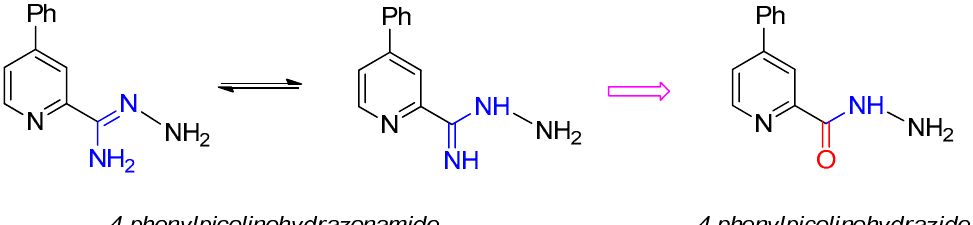
Figure 2. Structures of the obtained 4-phenylpicolinohydrazonamide and its isoster, 4-phenylpicolinohydrazide.